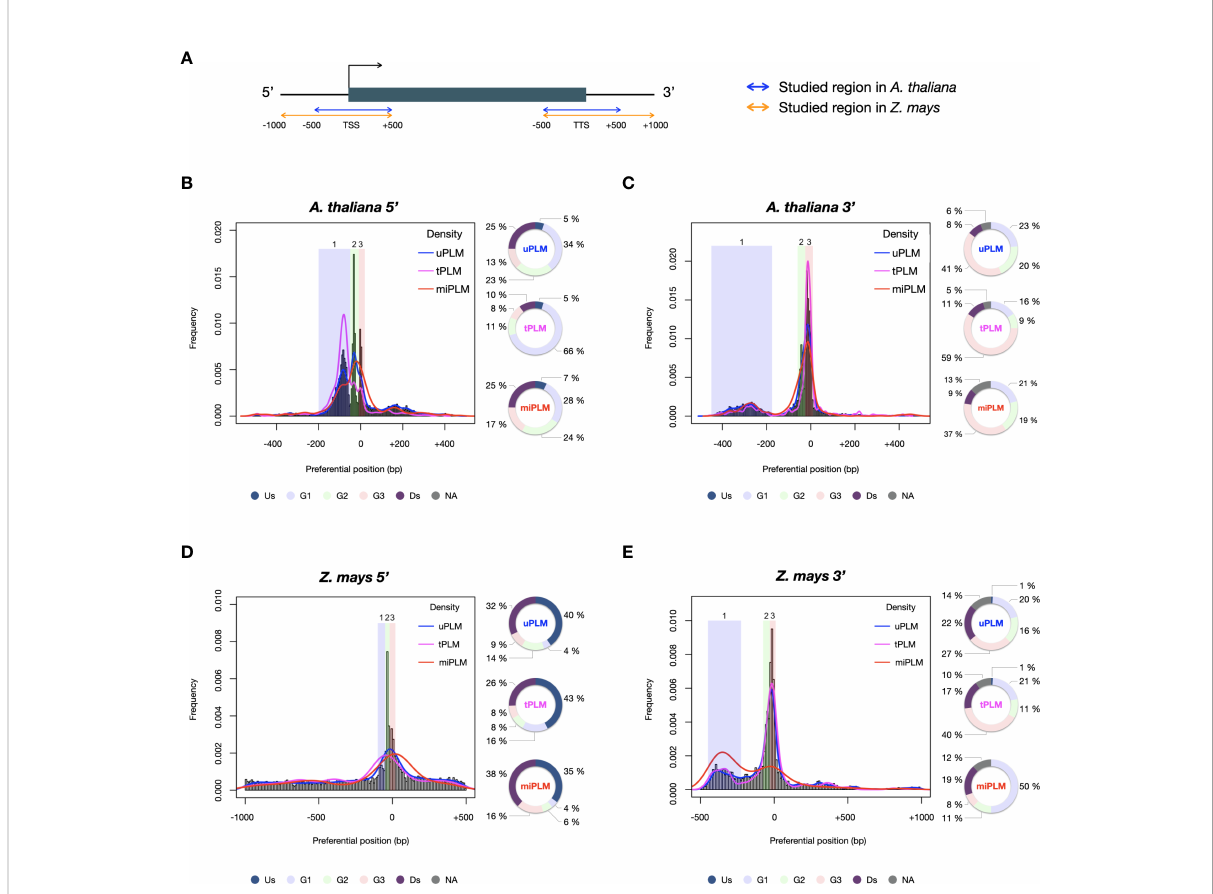
FIGURE 3 PLM frequency and characterization according to their preferential position. (A) Schema of the studied regions with respect to the gene in A. thaliana and Z. mays. (B) 5 ’ -PLMs in A. thaliana. Group 1: [-200;-50[; Group 2: [-50;-10[; Group 3: [-10;+20[. (C) 3 ’ -PLMs in A. thaliana. Group 1]:-450;-175]; Group 2]:-60;-25]; Group 3]:-25;+10]. (D) 5 ’ -PLMs in Z. mays. Group 1: [-100;-50[; Group 2: [-50;-20[; Group 3: [-20;+20[. (E) 3 ’ - PLMs in Z. mays. Group 1]:-450;-225]; Group 2]:-75;-30]; Group 3]:-30;+10 bp]. Us: region located upstream the three groups; G1, G2 and G3: groups 1, 2 and 3; Ds: region located downstream the three groups; NA: region located between the groups when they are not